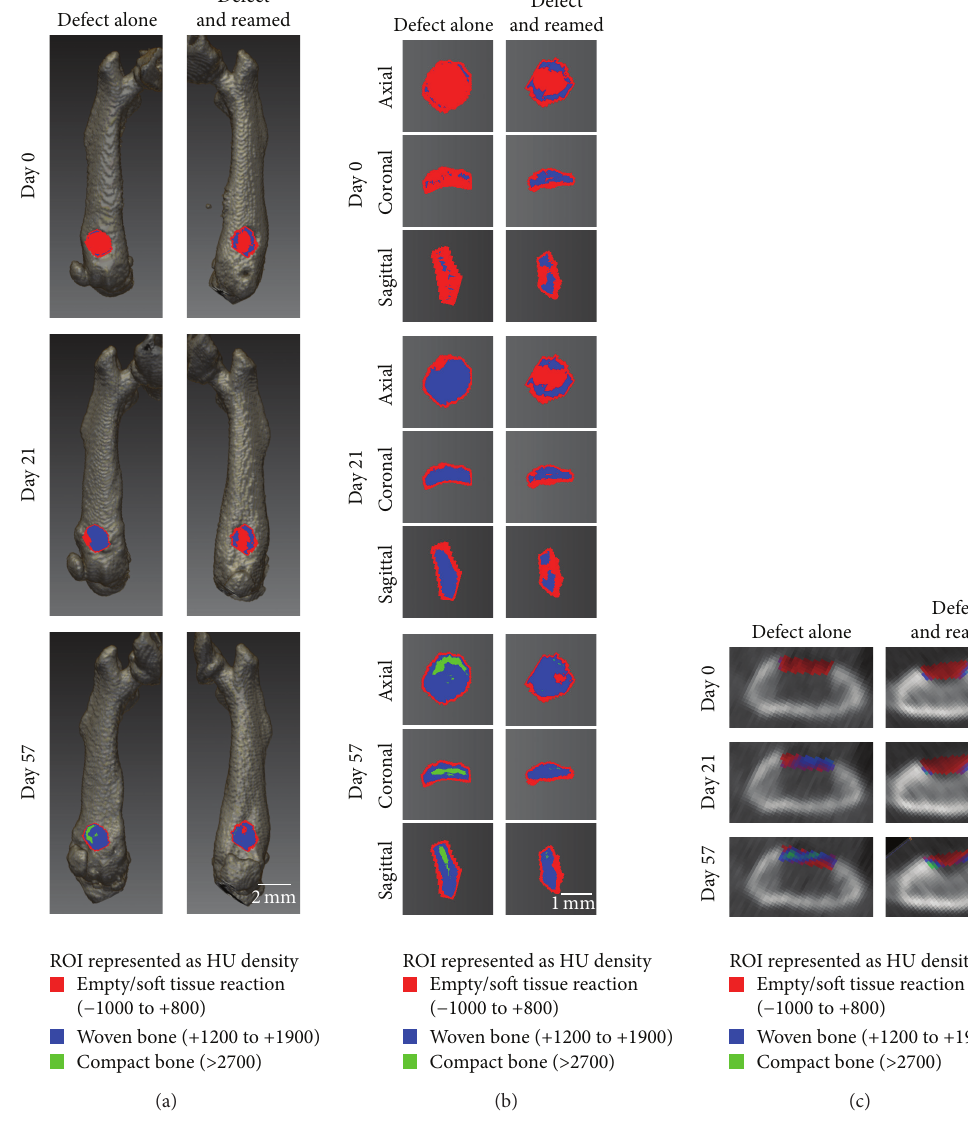
Figure 3: Bone healing monitoring as a function of time using low dose 𝜇 CT scans of live mice. (a) Representative views of 3D 𝜇 CT reconstructed images of femurs on days 0, 21, and 57 after surgery. Variations in the density of the 3D ROI (determined at day 0 after surgery) make it possible to estimate the tissue composition. (b) 3D ROI can also be observed in axial, coronal, and sagittal views. (c) Representative cross-sectional views of the femur in which the 3D ROI is apparent in one image (slice). The colored voxels make it possible to see changes in defect composition as a function of time where most of the voxels were red on day 0 and blue on day 28, with an increasing proportion of green on day 57. Nonorganized substrate (red: − 1000 to +800 HU), woven bone (blue: +1200 to +1900HU), and compact bone (green; > 2700